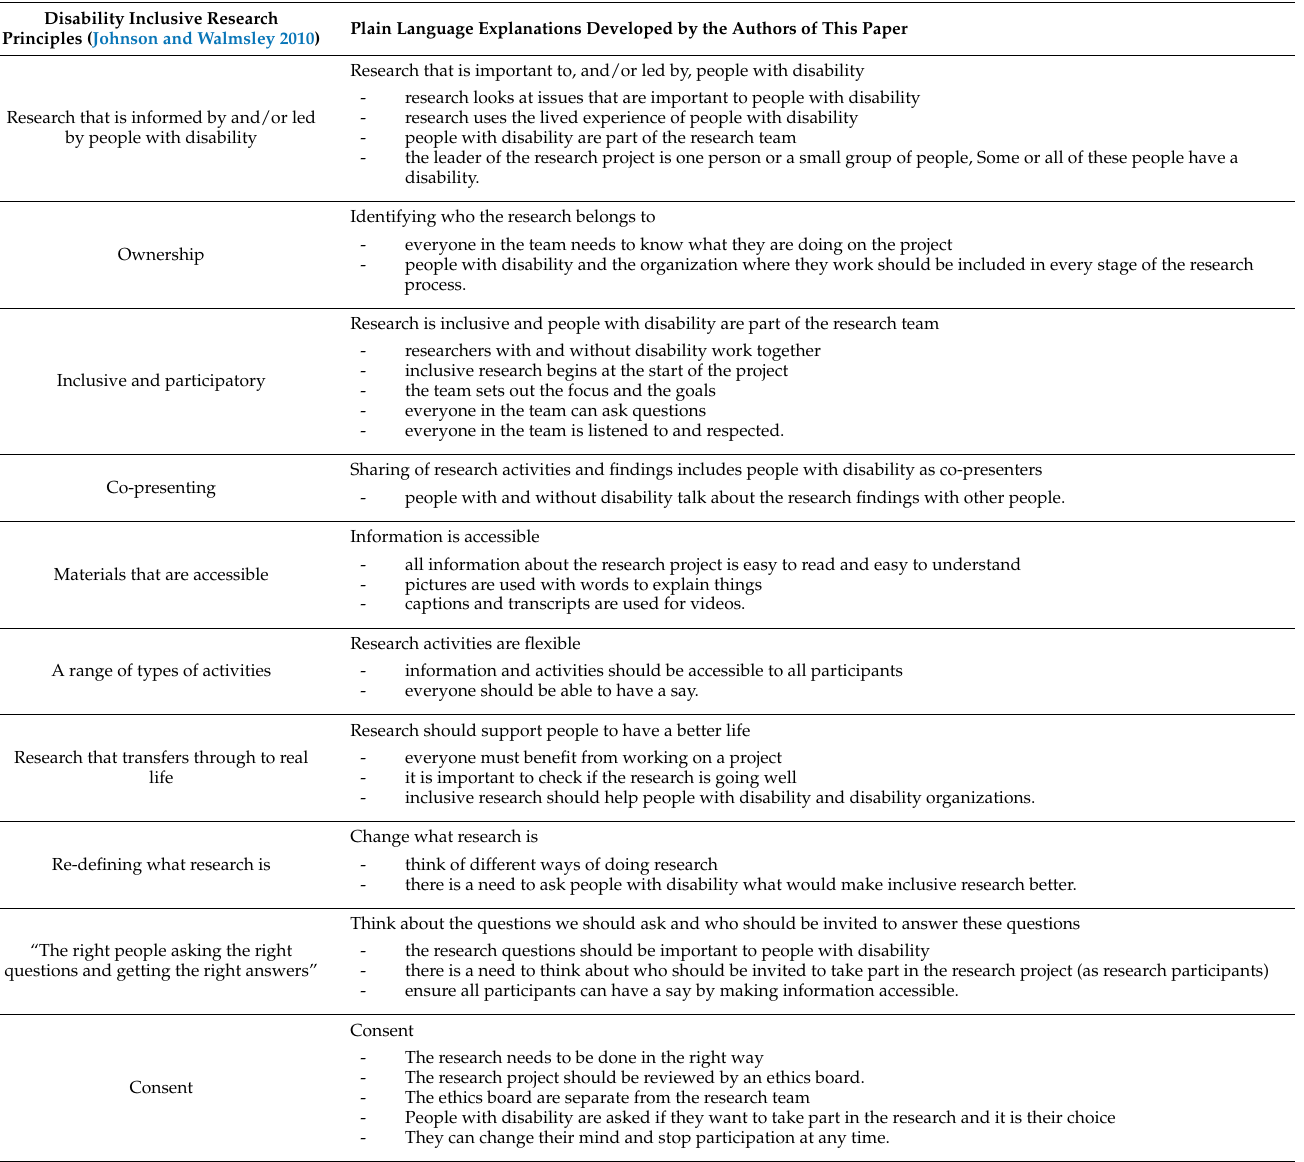
Table 1. Disability Inclusive Research Principles with Plain Language